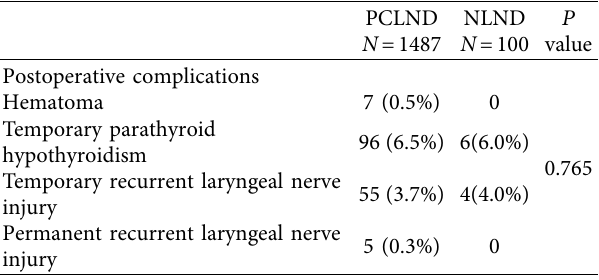
Figure 1: Kaplan–Meier curve of local recurrence-free survival. PCLND, prophylactic central lymph node dissection; NLND, no lymph node dissection. Table 3: Postoperative